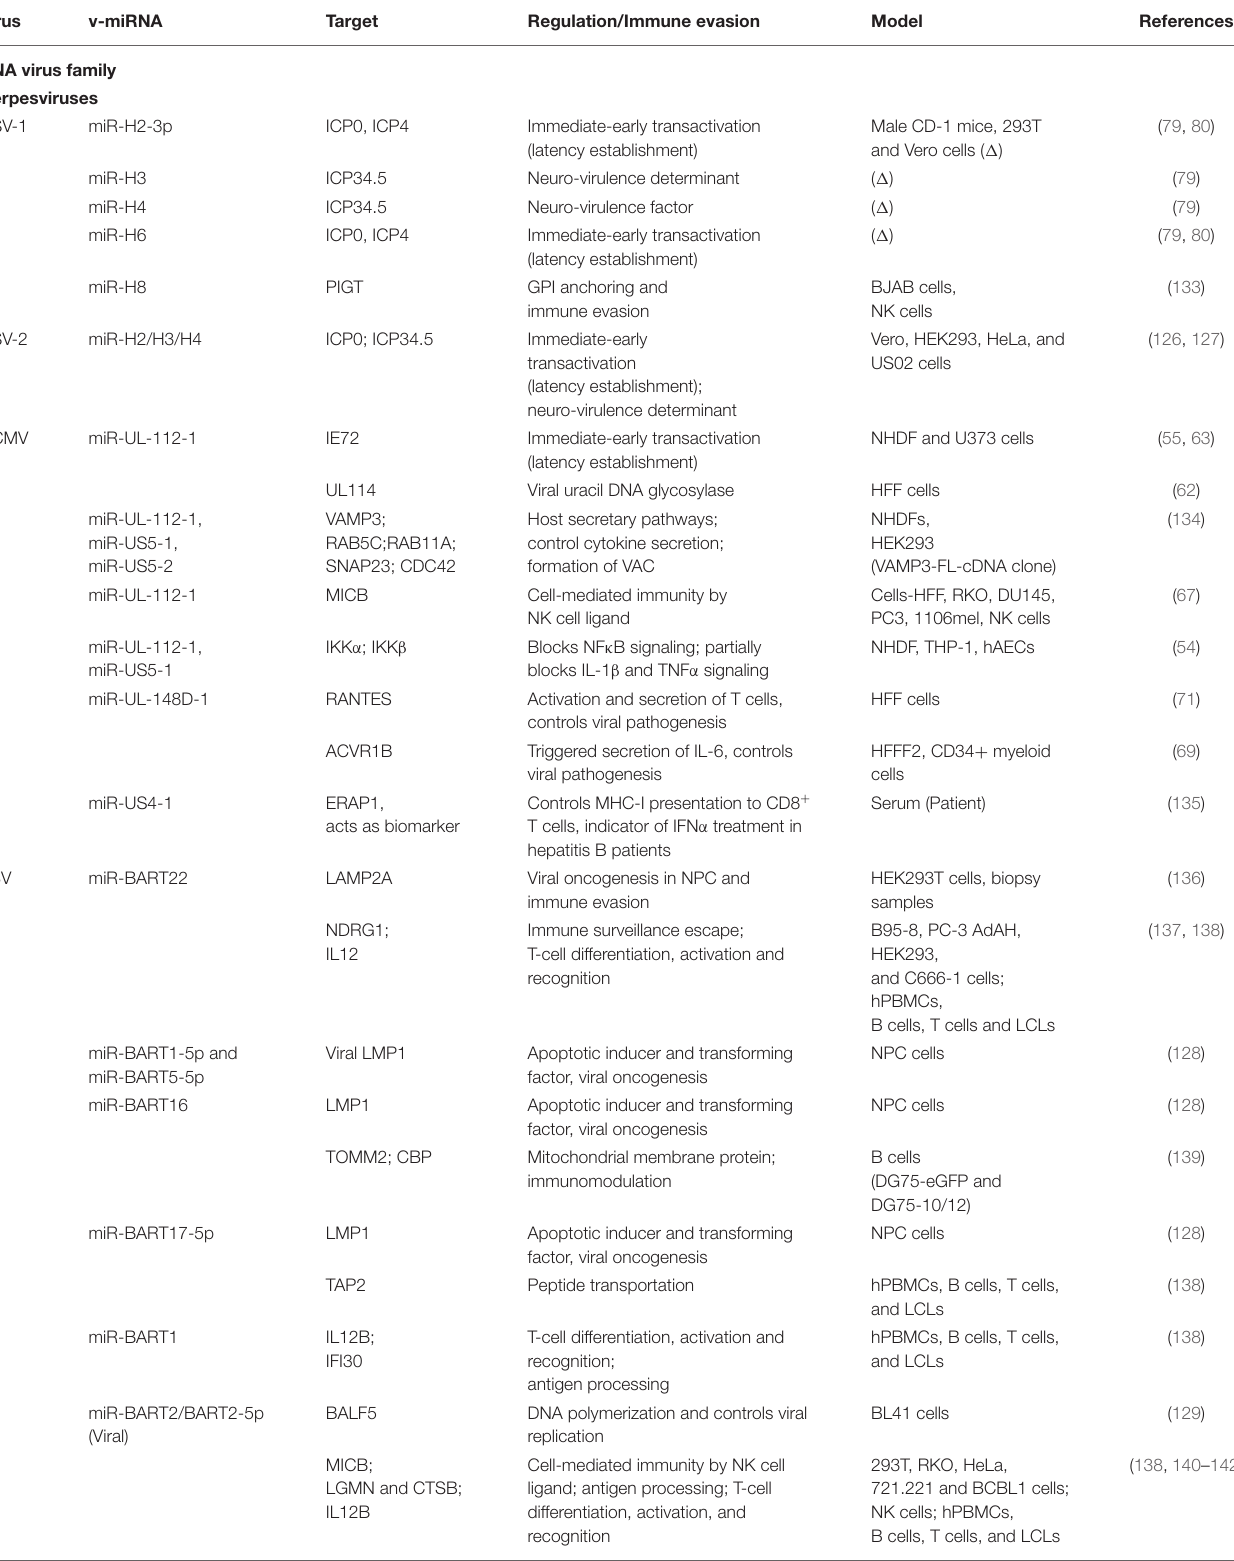
TABLE 1 | Viral miRNAs with regulatory functions and immune evasion approaches. Virus DNA virus family